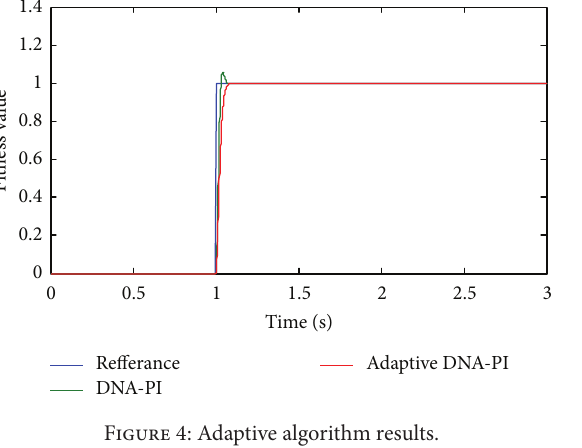
Figure 4: Adaptive algorithm results.